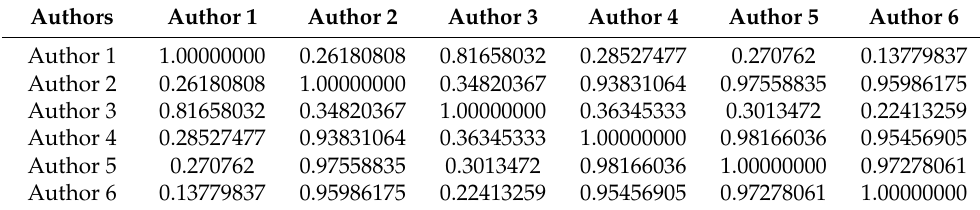
Table 9. Similarity matrix between authors based on topics’